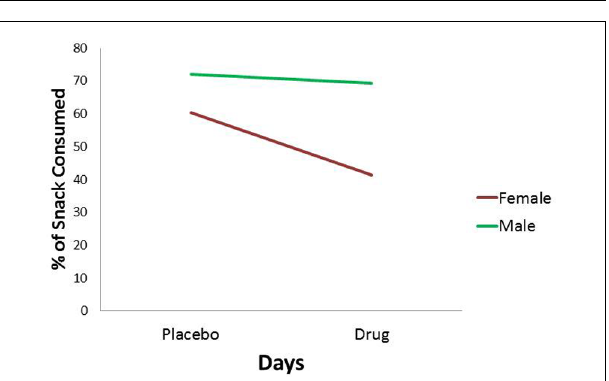
FIGURE 3 | Plot for the Diagnostic Group × Days interaction with percentage of snack-food consumption as the dependent variable.